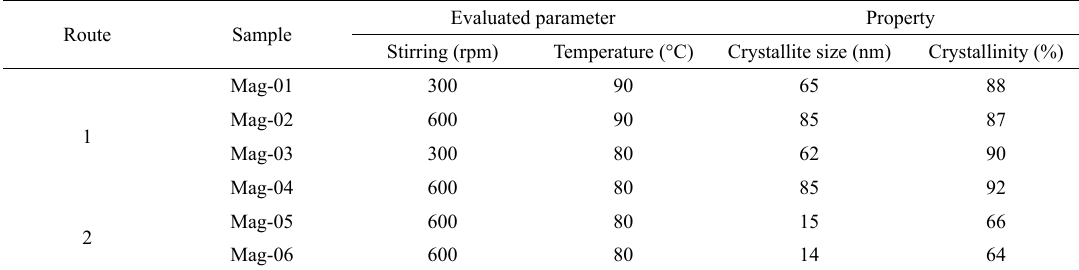
Table 2. Magnetite (Fe